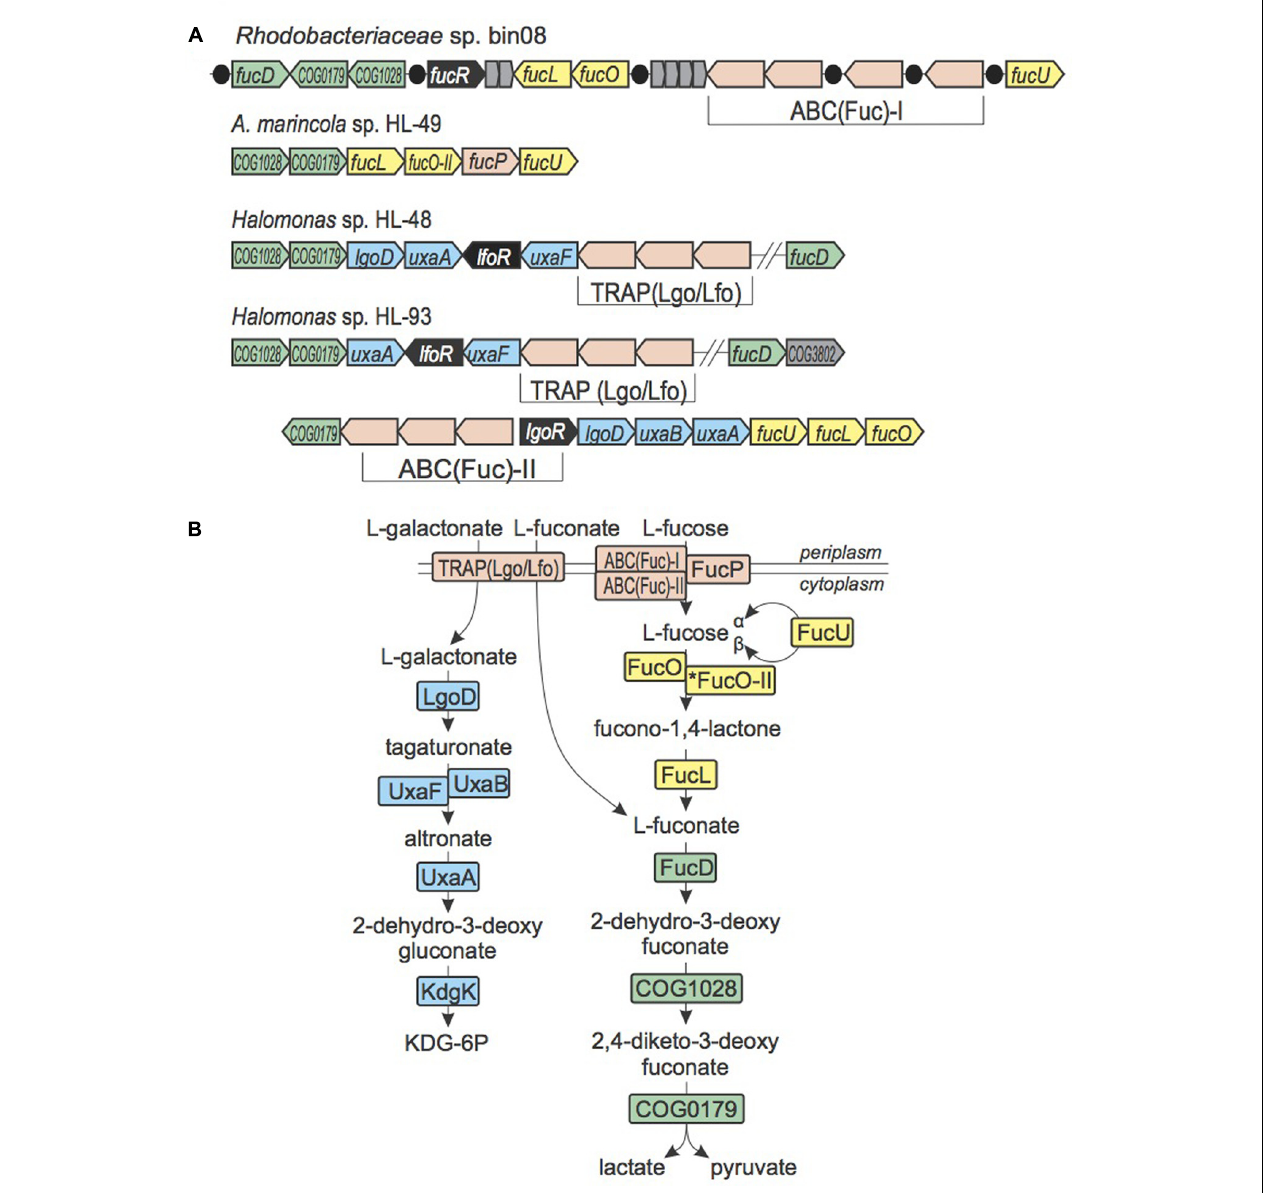
FIGURE 3 | L -Fucose, L -fuconate, and L -galactonate utilization in UCC bacteria. (A) Loci containing L -fucose, L -fuconate, and L -galactonate utilization genes. Genes are colored by their general functional roles: transcription factors (black), transporters (pink), uncharacterized genes (gray), enzymes from L -galactonate utilization pathway (blue), enzymes from the L -fucose utilization pathway (yellow), enzymes from the L -fuconate utilization pathway (green). Predicted DNA binding sites of FucR are shown as black circles. (B) Scheme of L -fucose, L -fuconate, and L -galactonate utilization pathways. Enzymes are colored by matching colors as in (A)